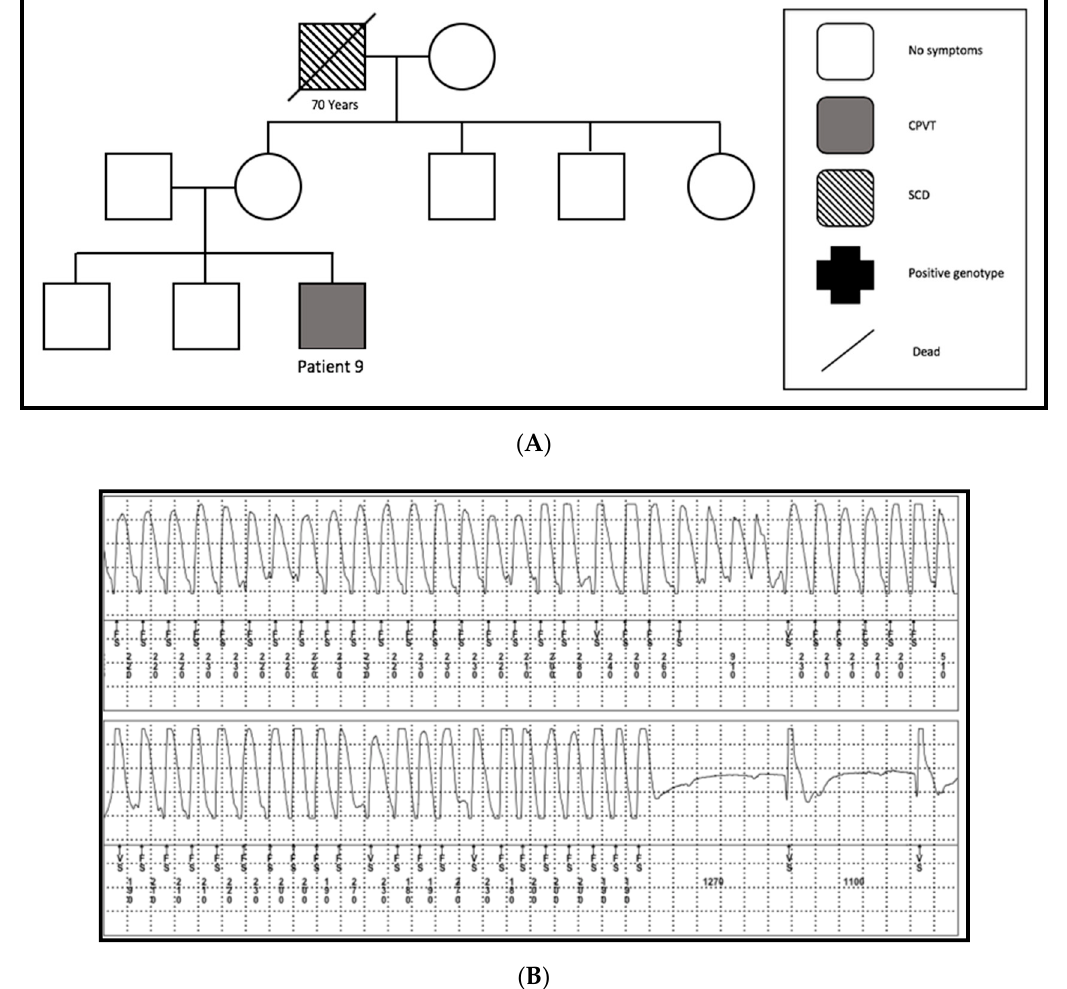
Figure 5. ( A ) Pedigree of family 7. One SCD at the age of 70 years (SCD = sudden cardiac death). ( B ) A representative chart of ventricular tachycardia of patient number 9 documented in his implanted event recorder during football.